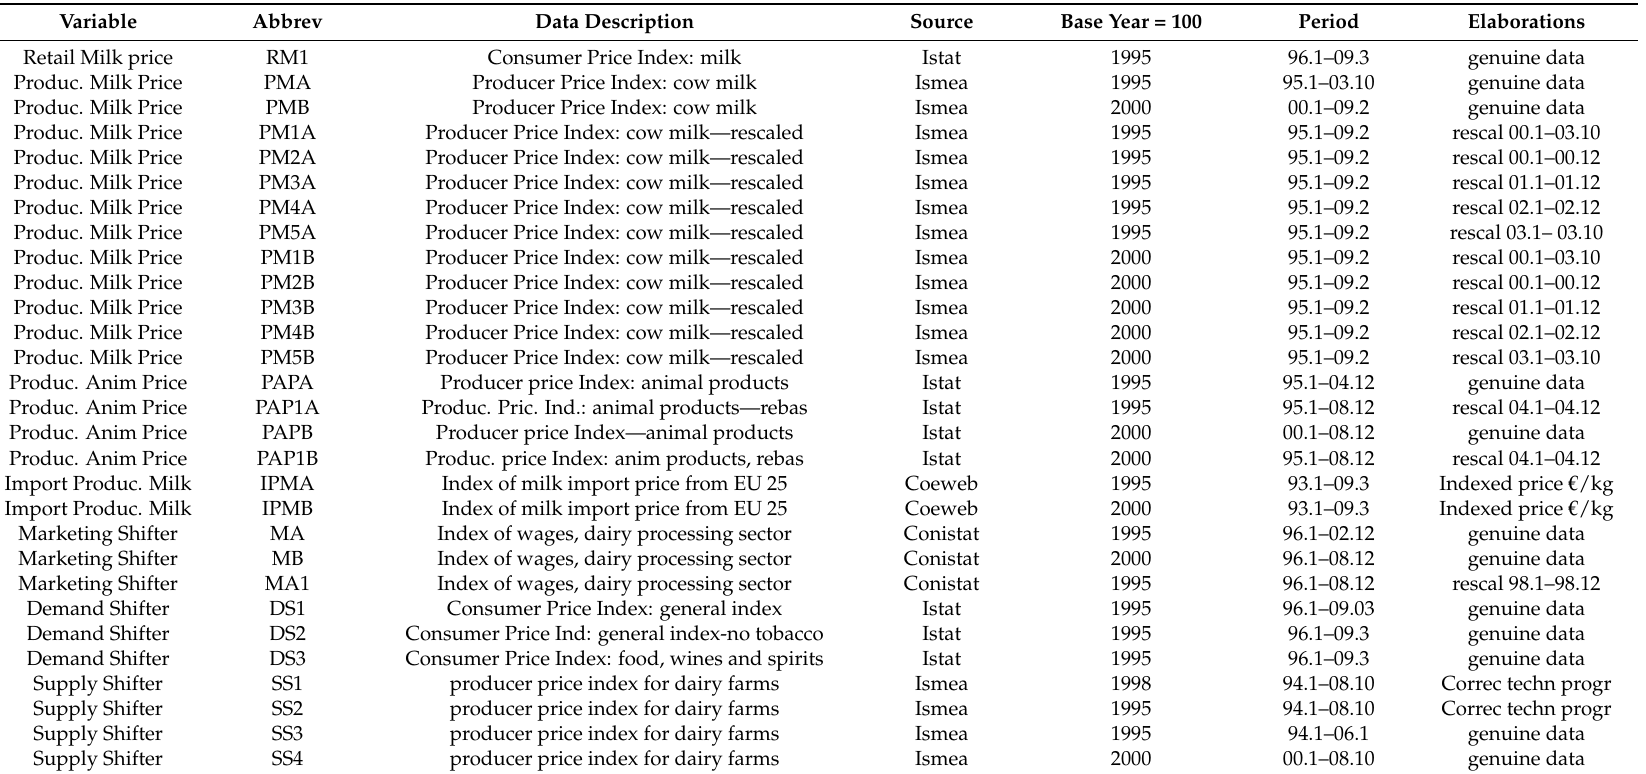
Table 1. Variables description and data